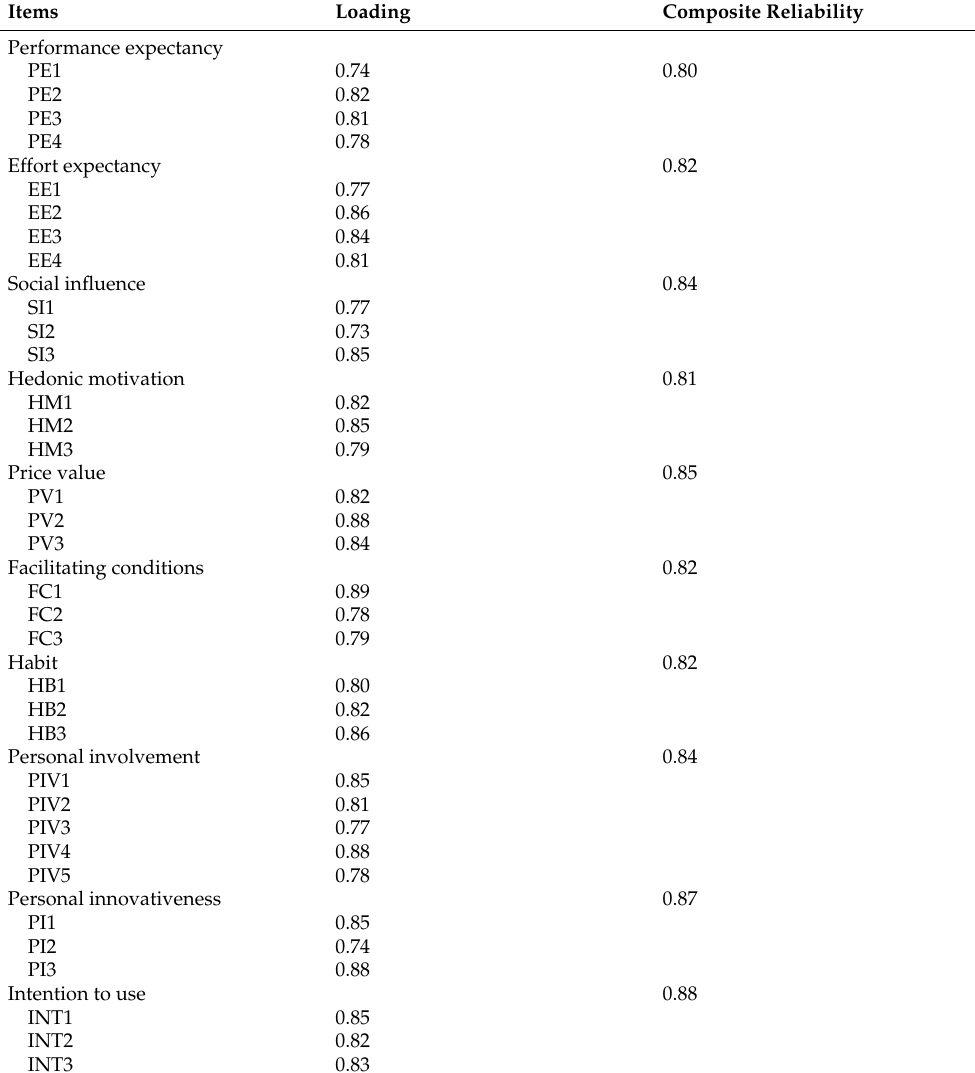
Table 1. Loadings and composite